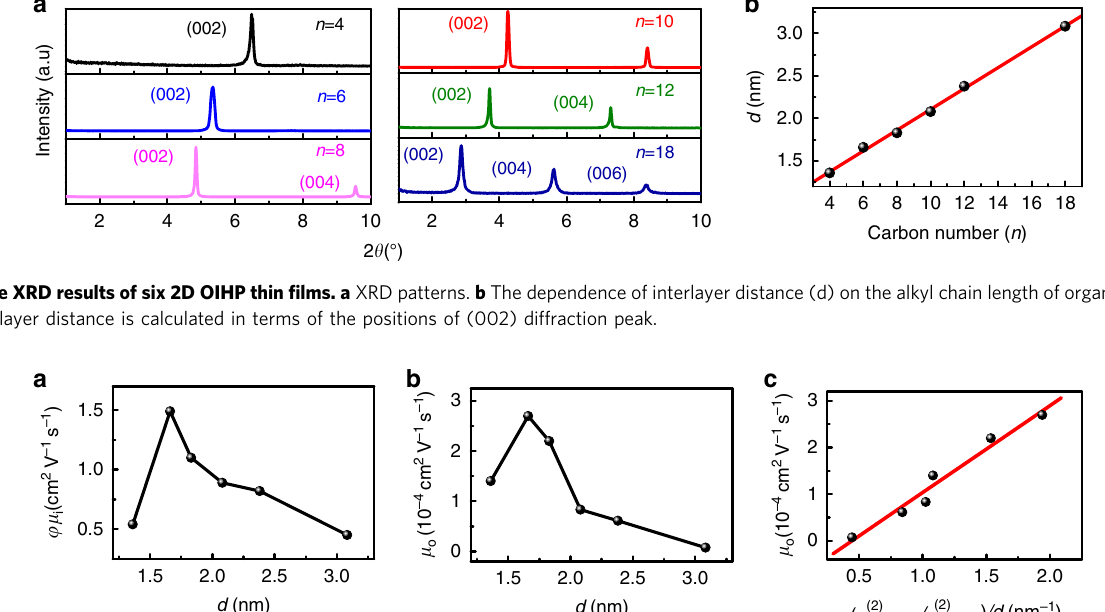
Fig. 5 The charge-carrier mobility is plotted against the interlayer distance or the ratio of ð χ 2 ð Þ ss (cid:2) interlayer distance. b The out-of-plane mobility versus interlayer distance. c The out-of-plane mobility versus the ratio of ð χ 2 ð Þ ss (cid:2)